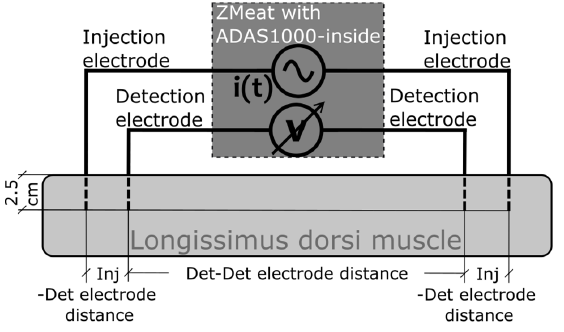
Fig.4: Schematic diagram of the Z Meat measures of the beef samples of longissimus dorsi muscles. Table 1. Distance between